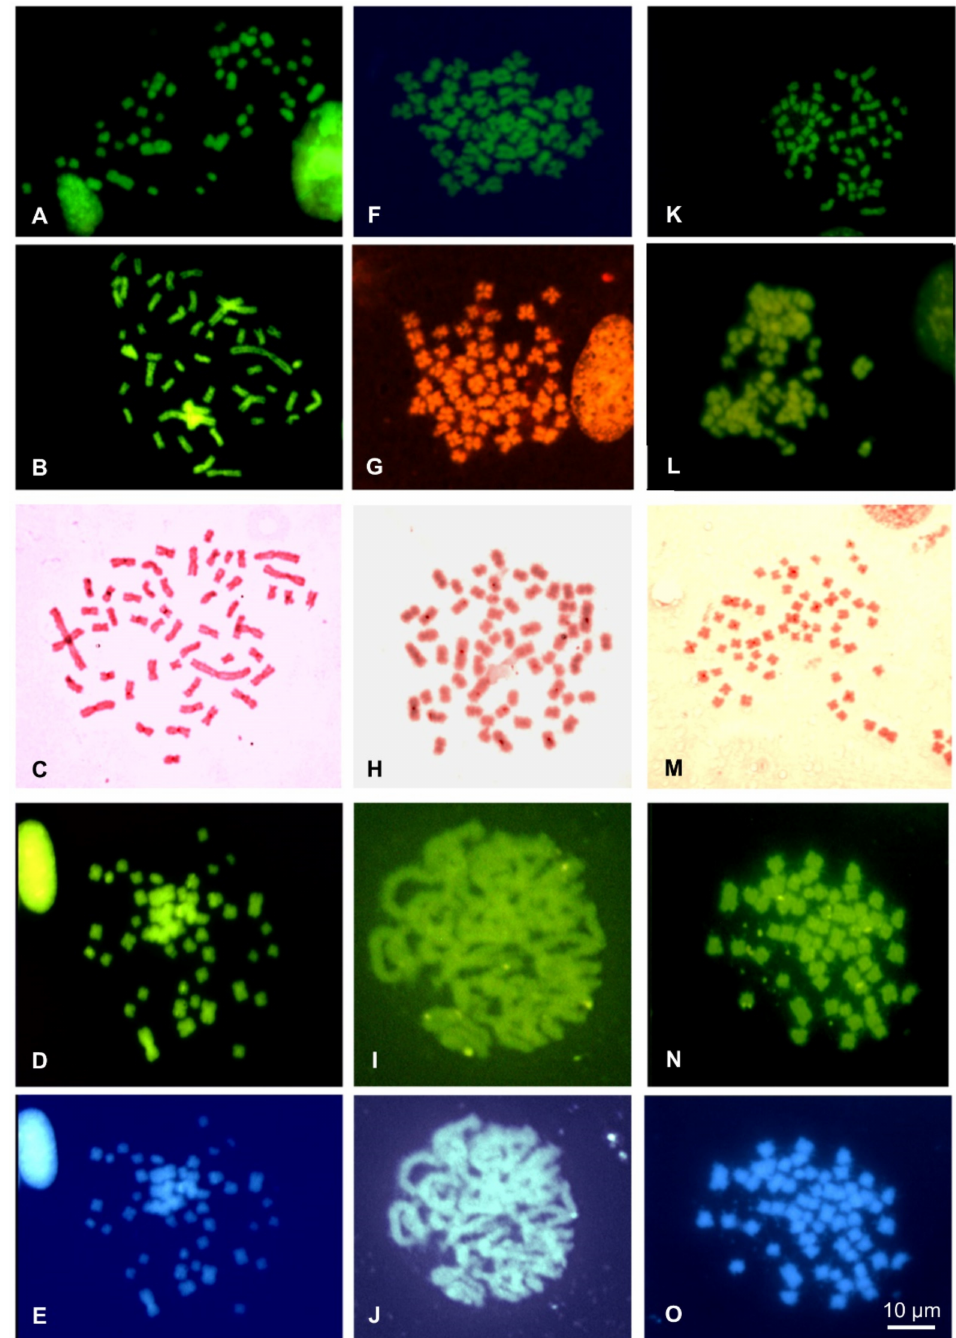
Figure 5. Metaphase plates of E. vermiculata ( A – E ), Theba pisana from Naples ( F – J ) and Theba pisana from Messina ( K – O ) stained with Quinacrine ( A , F , K ), CMA 3 /MG ( B , G , L ), C-banding Giemsa ( C , H , M ) and sequential C-banding + CMA 3 ( D , I , N ) + DAPI ( E , J , O